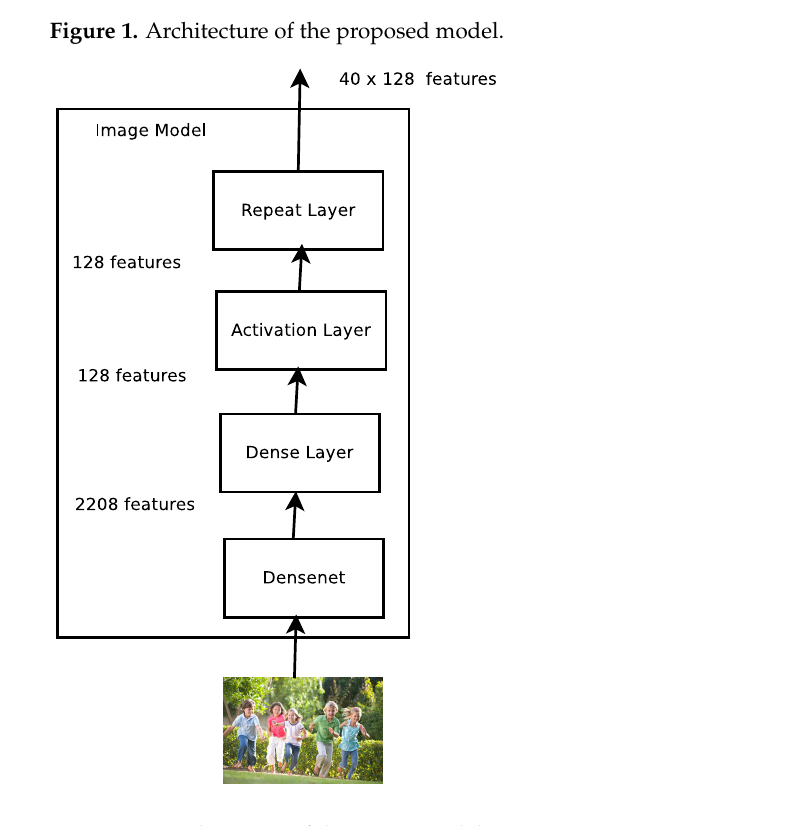
Figure 2. Architecture of the image